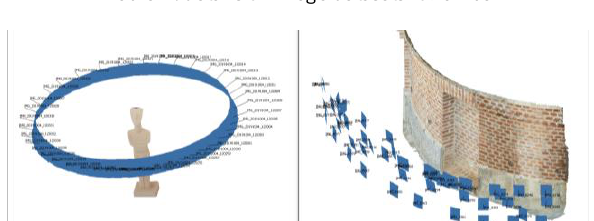
Table 4: details of image datasets for OBJ3